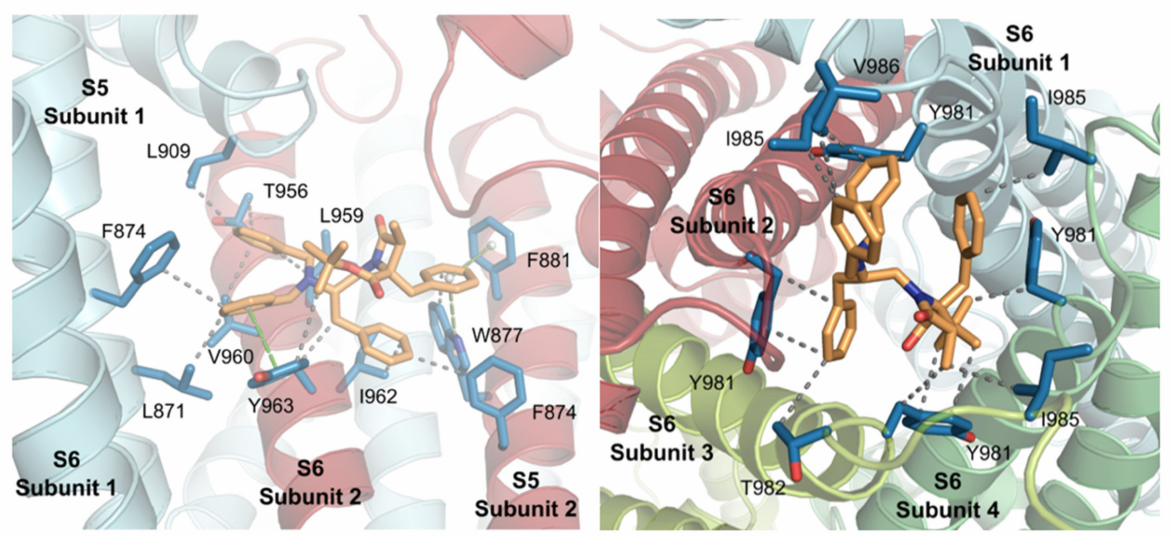
Figure 5. Interaction of β –lactam RGM8-51 (carbon atoms in wheat color) at subsite 1 ( left ) and subsite 2 ( right ). Channel residues involved in the interactions are shown in blue. WdV interactions are indicated by doted gray lines, and π – π stacking by centroids and non-continuous pale green